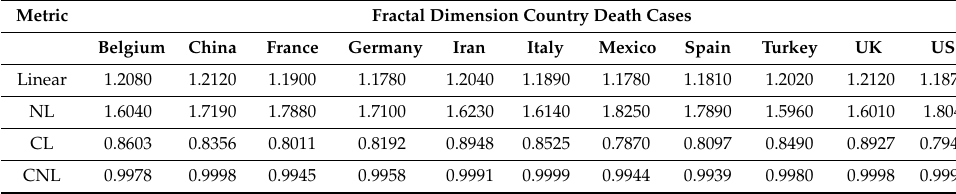
Table 2. Fractal dimensions for death cases in the countries.